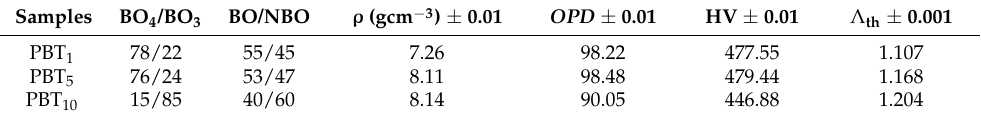
Table 2. The ratio of BO 4 /BO 3 and BO/NBO from the calculation of the XPS deconvolution area, Vick- ers hardness of samples (HV), density ( ρ ), oxygen packing density ( OPD ), and optical basicity ( Λ th ).